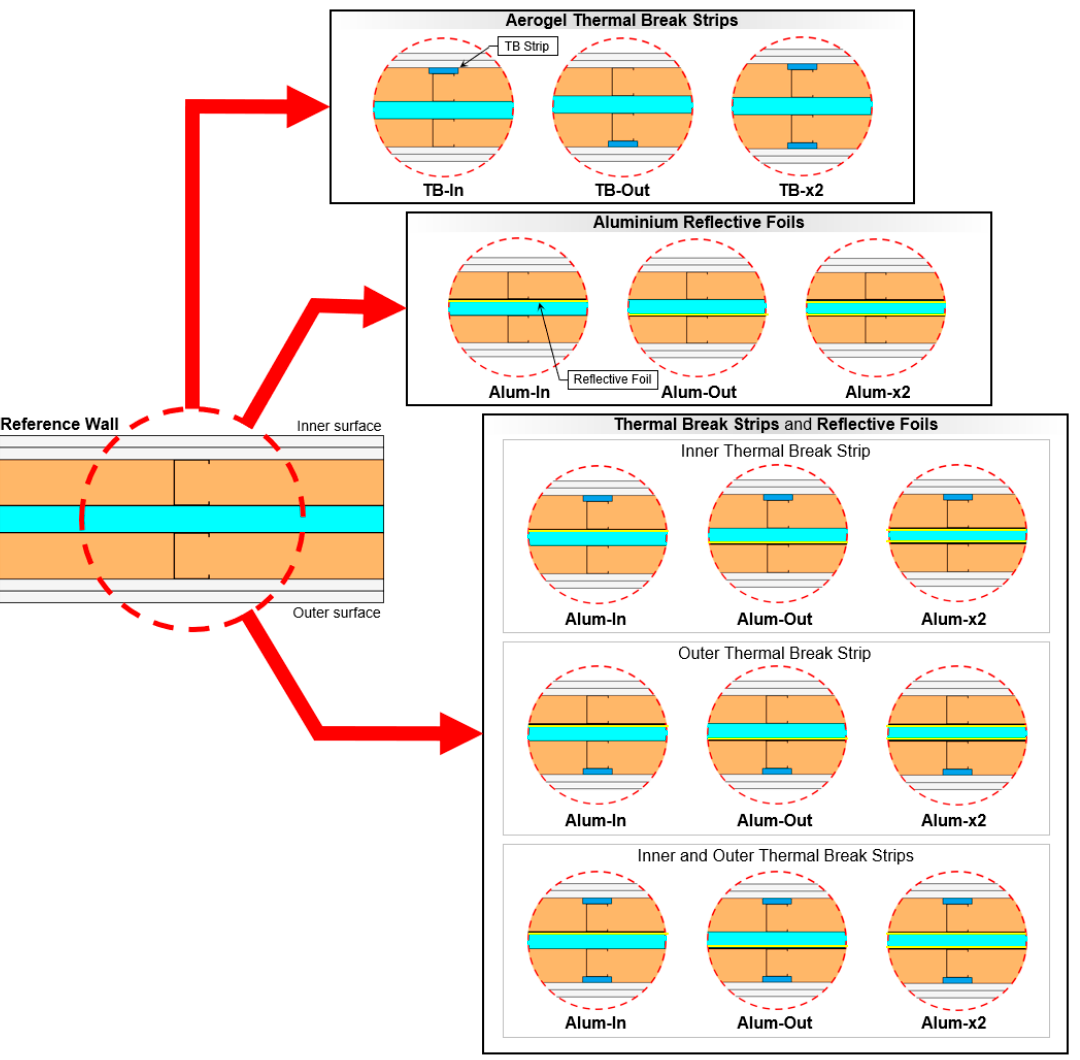
Figure 2. Wall configurations tested using aerogel thermal break (TB) strips and aluminium reflective foils. Regarding the localization of the reflective foils, three configurations were considered (Figure 2): (i) along the inner side of the air cavity; (ii) along the outer side of the air cavity; (iii) along both sides of the air cavity. These two elements (aerogel TB strips and aluminium reflective foils) were tested separately, as well as combined, resulting in a total of fifteen wall configurations, as schematically illustrated in Figure 2. 2.2. Experimental Lab Tests 2.2.1. Experimental Setup The lab measurements were performed using a mini hot box apparatus, as illustrated in Figure 3a. This equipment is composed of two climatic chambers: (i) a hot box heated by an electric resistance; (ii) a cold box cooled by a refrigerator. The double-pane LSF wall test sample was placed between these two chambers, as displayed in Figure 3b,c. To minimize the amount of heat that is lost through the lateral surfaces of the sample, its perimeter was covered with 80 mm thick polyurethane foam insulation (Figure 3a).